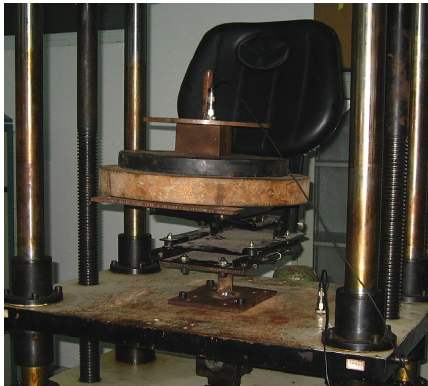
Figure 8: Site map of stiffness and damping test rig for the driver